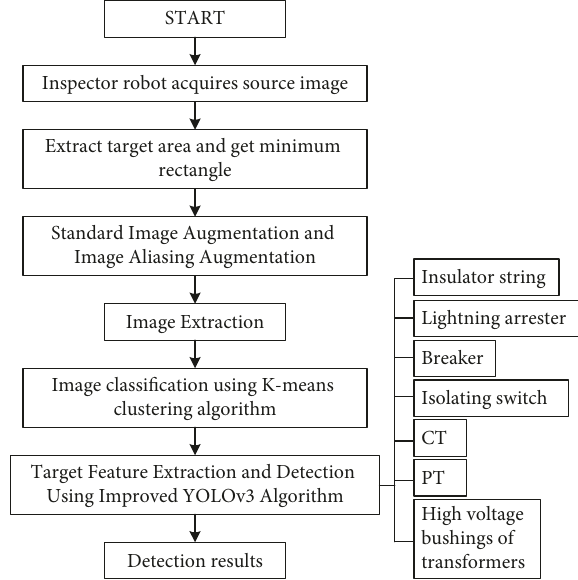
Figure 6: The process of the proposed detection